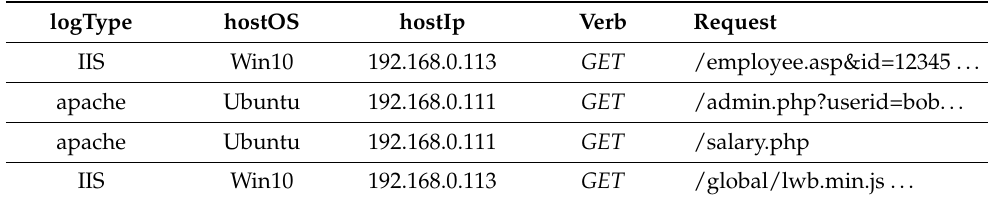
Table 1. Web access query result (excerpt).